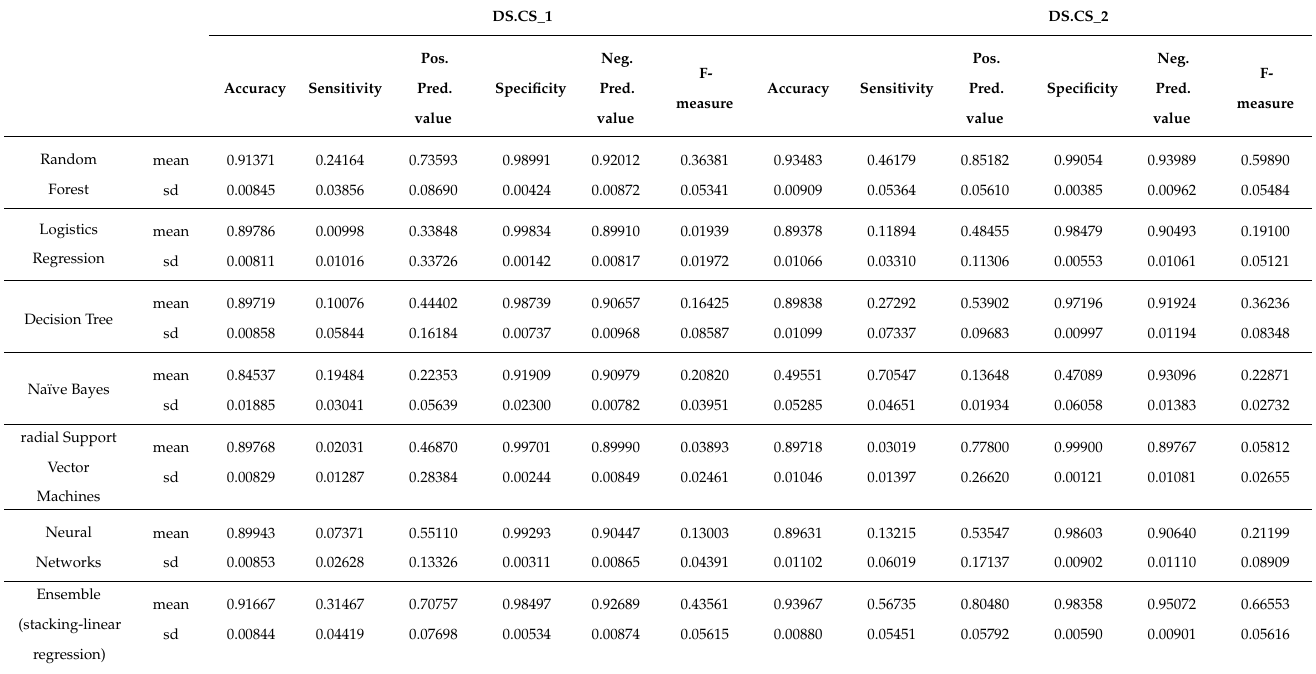
Table 4. Classification Algorithms